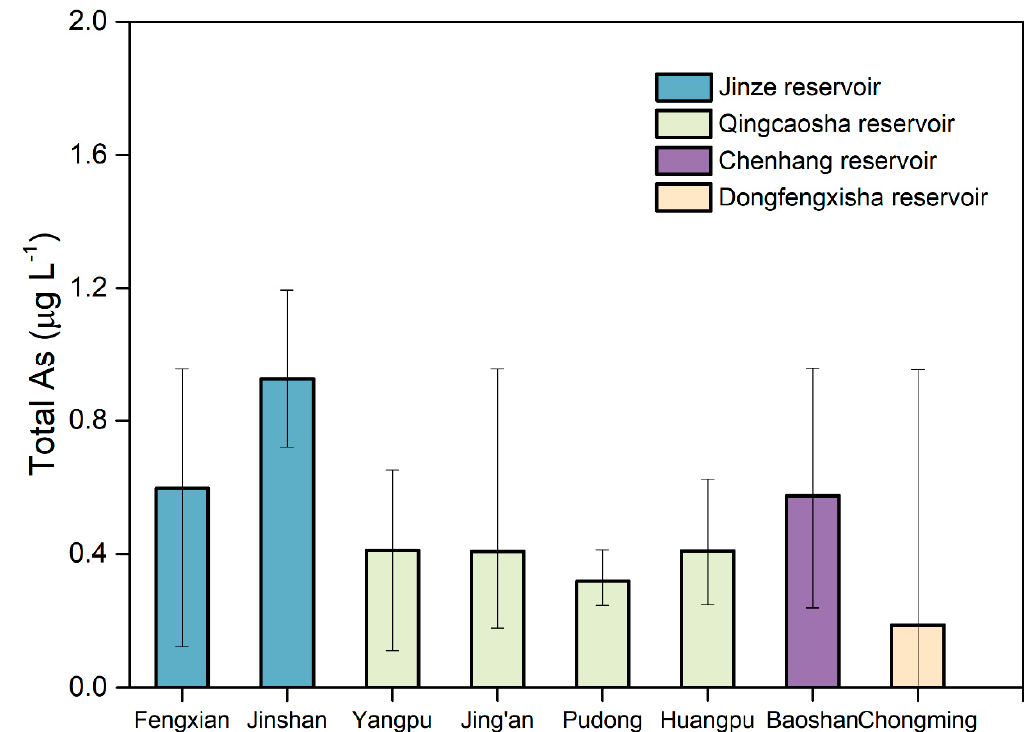
Figure 4. Distribution of total arsenic in the end water of Shanghai pipeline network.